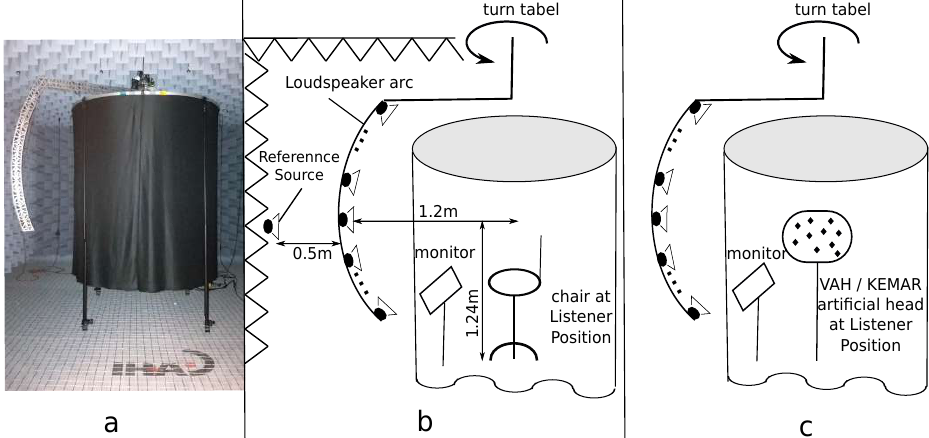
Figure 3. ( a ) An acoustically transparent tent and the loudspeaker arc in the anechoic room. ( b ) Ex- perimental setup during TestReal and TestVR (during TestReal, the loudspeaker arc was used to represent the target sources. During TestVR, virtual target sources were presented over